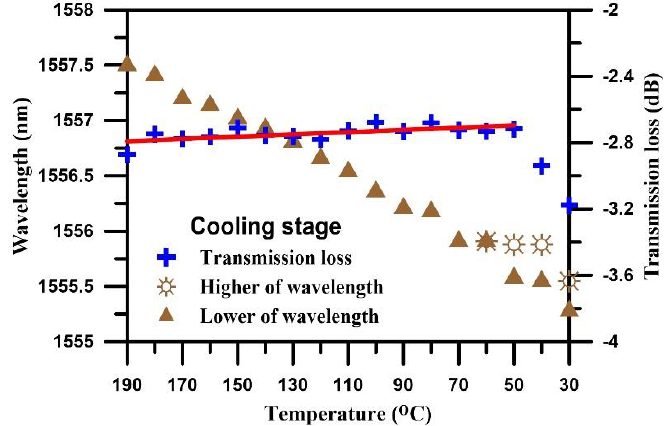
Figure 11. Temperature dependence of wavelength and transmission loss when cooling stage.